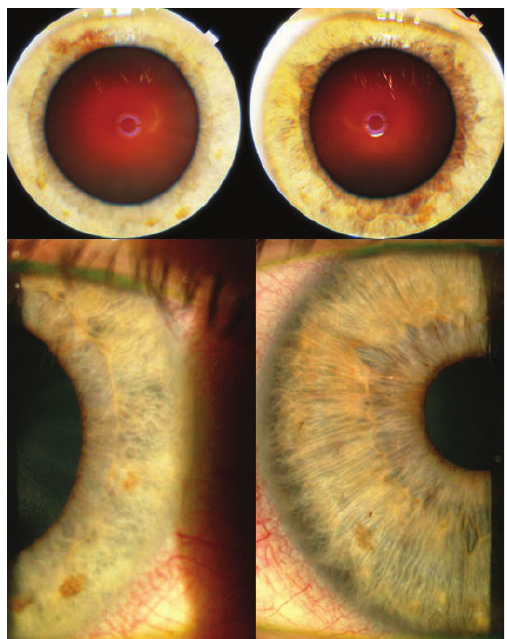
Figure 2. Heterochromia with a lighter-colored iris on the right (top). Bottom two pictures show a right discolored iris with an altered hyalinized iris texture (left